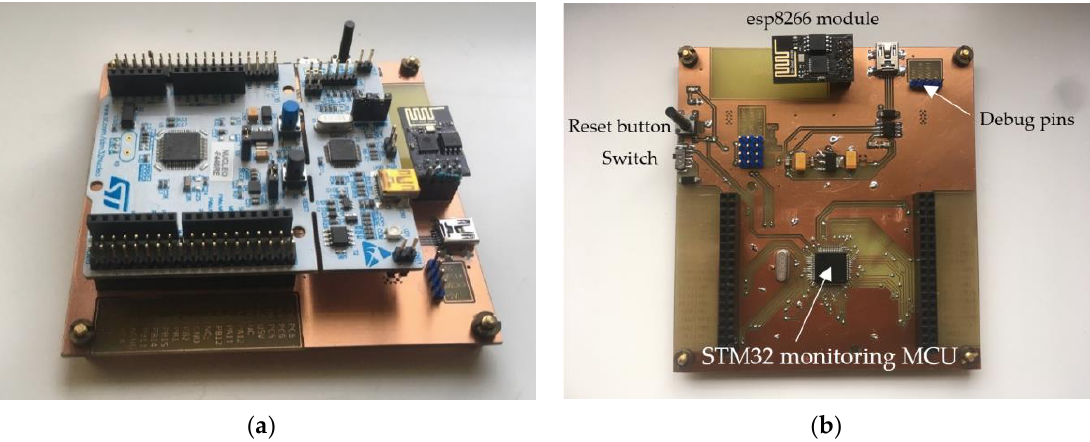
Figure 3. A hardware part of the IoT remote laboratory: Student Nucleo-64 board connected to the IoT monitoring device ( a ) and created PCB ( b ) with equipped monitoring microcontroller STM32F446RE, IoT module esp8266, and the other required